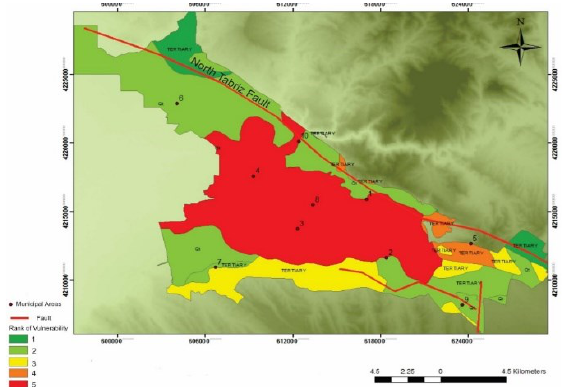
Fig. 5. Seismic vulnerability map of Tabriz city